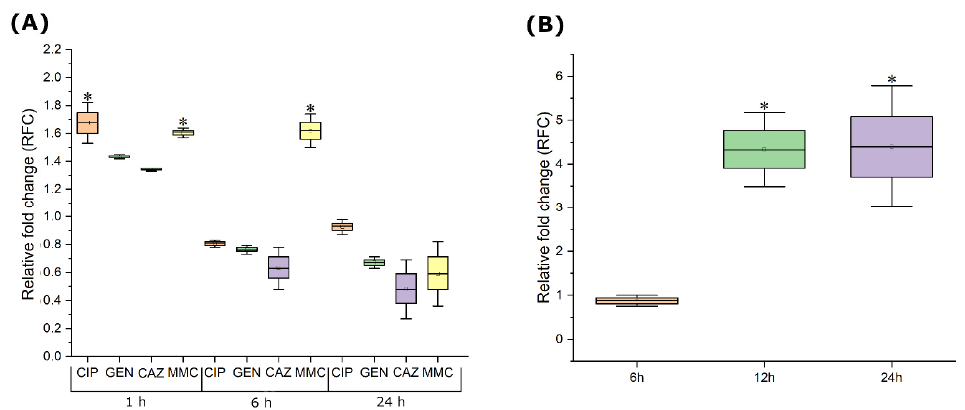
Figure 1. Change of Pf4 coaB and zot gene expression in PAO1 strain after ( A ) treatment with 1 / 4 MIC of CIP (light orange), GEN (green), CAZ (purple), and MMC (light yellow) and ( B ) infection with phage JG024 at MOI 0.25 (equivalent to 1 MIC). Results are average + S.E., n = 6; calculated using 4 2 − ∆∆ CT method, and cut-off for relative change in expression was ≥ 1.5 or ≤ 0.67; * ≥ 1.5.